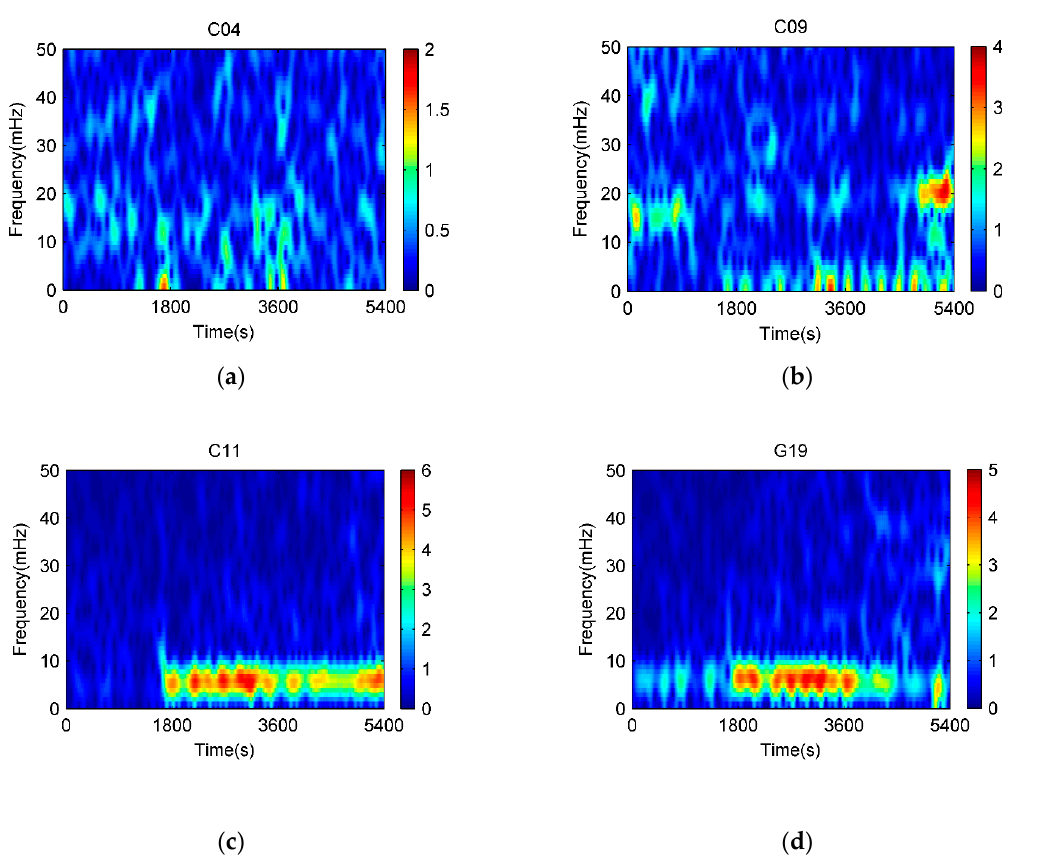
Figure 5. Spectrums of code multipath on DOY 310 (from 9:00 a.m. to 10:30 a.m. local time). ( a ) C04, ( b ) C09, ( c ) C11, and ( d ) G19.